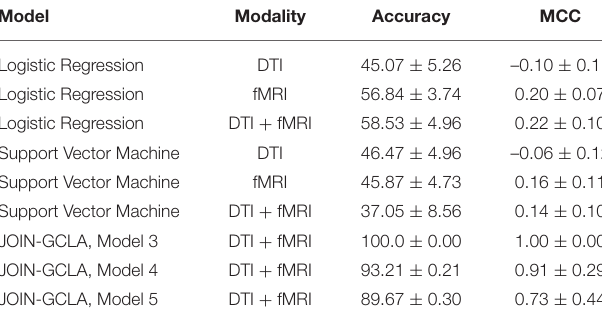
TABLE 6 | Comparison between alternative fusion approaches and JOIN-GCLA.